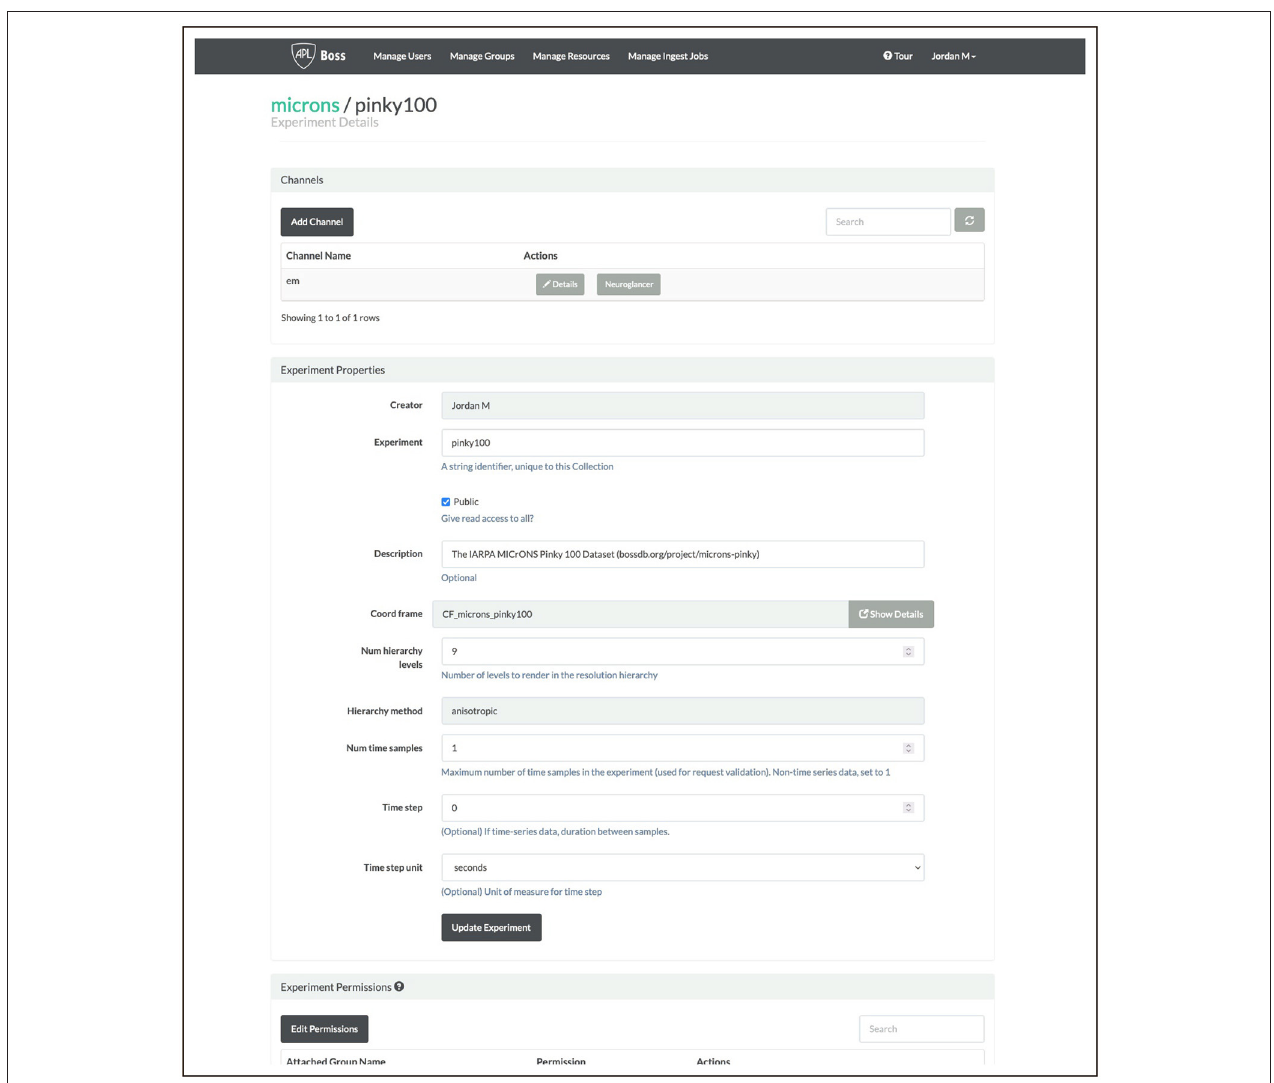
FIGURE 8 | An example screenshot from our BossDB console for the MICrONS Pinky dataset (see text footnote